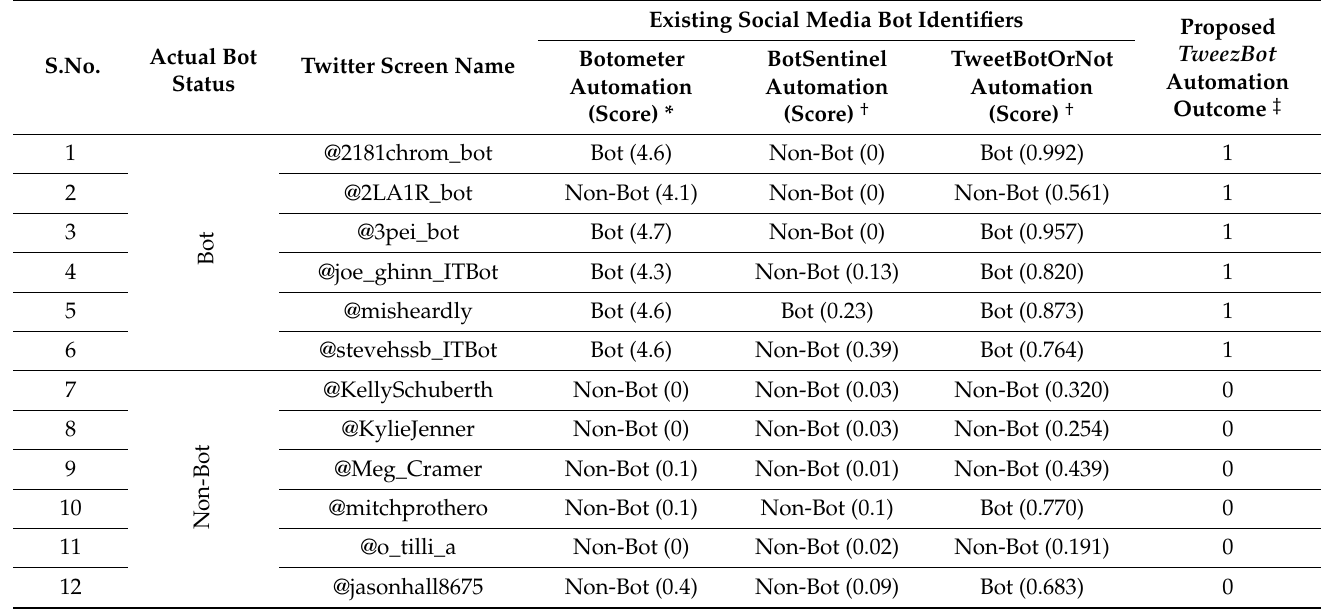
Table 5. Comparative Evaluation of Automation Scores from Existing Bot-APIs & Proposed TweezBot